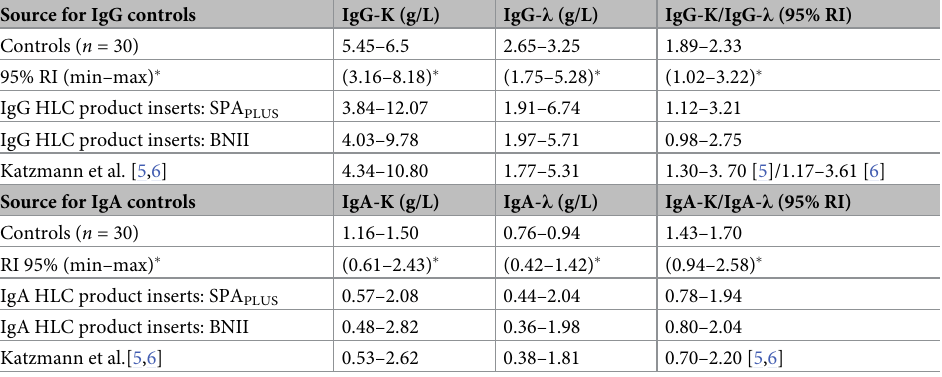
Table 1. Reference ranges for serum IgG and IgA heavy-light chain concentrations, based on samples from healthy individuals (controls) and previously published